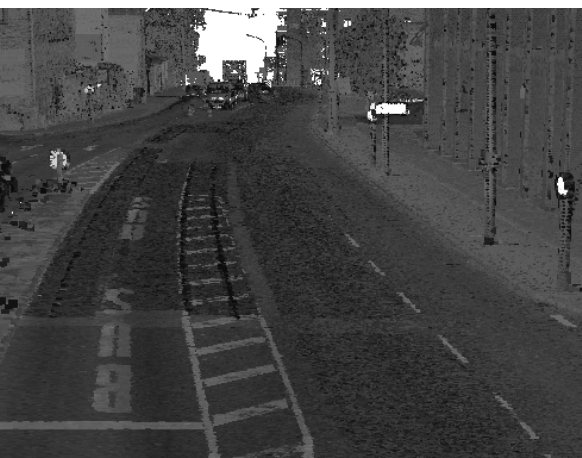
Figure 1. Visualization of a 3D point cloud of a road environment.